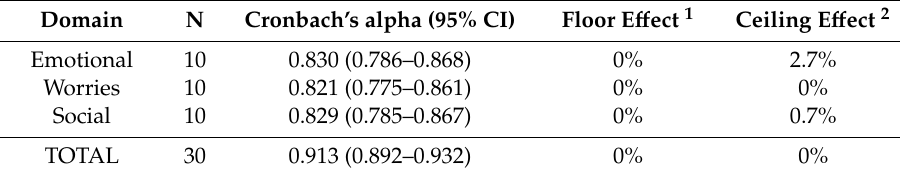
Table 1. Internal consistency of the questionnaire by its